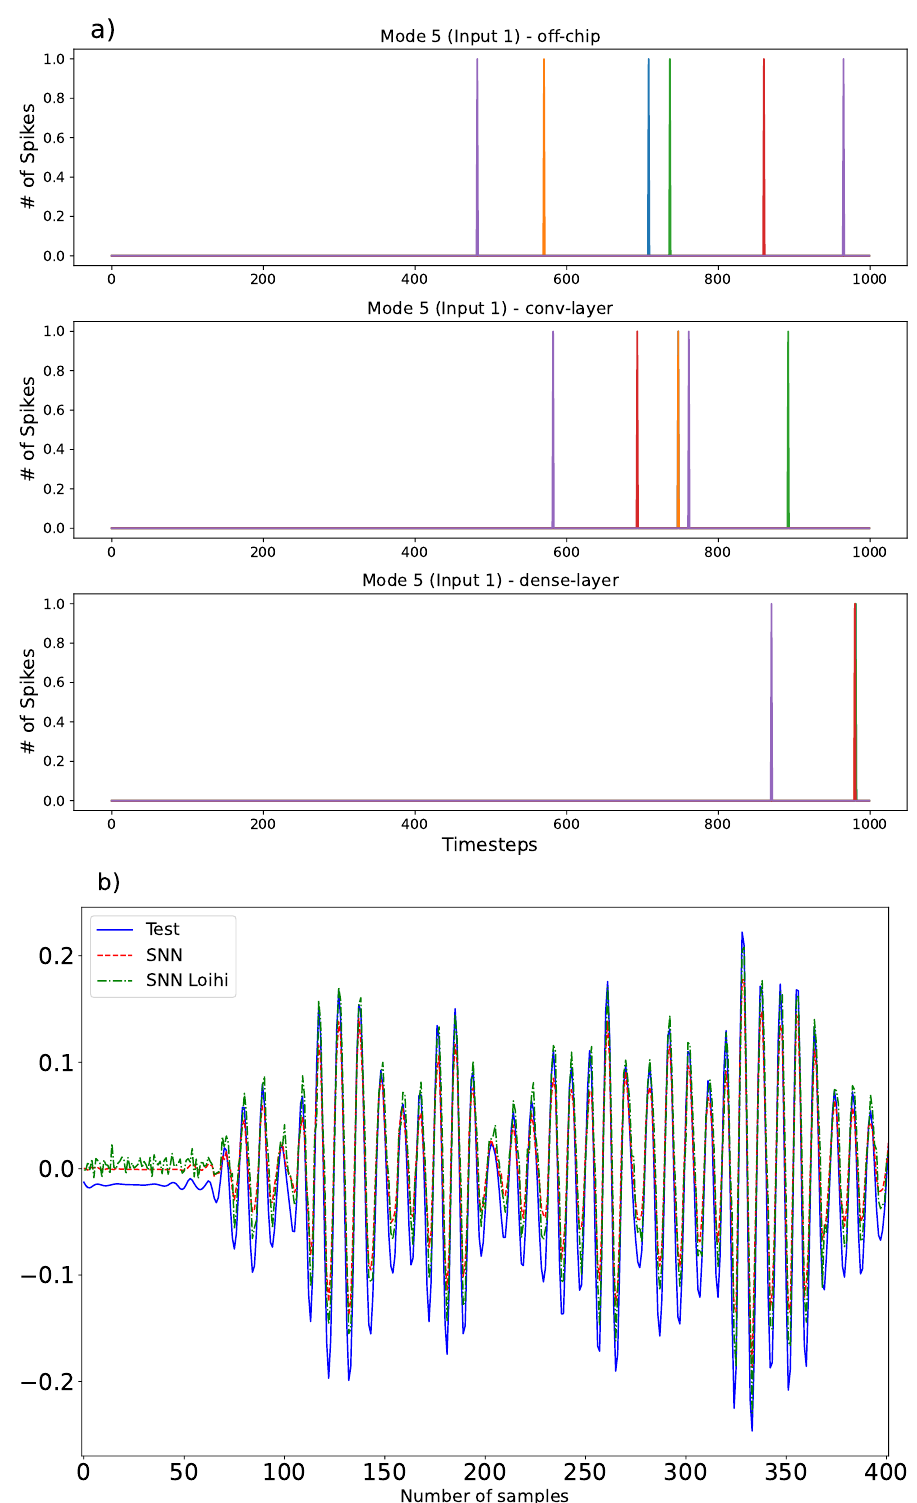
Figure 11. Results for mode 5: ( a ) Neural activities of 5 neurons of each layer. One input vector is shown over 1000 timesteps. ( b ) Predictions over the testing set with the SNN architecture (dashed red line) and running the SNN on the Loihi emulator (dash-dot green